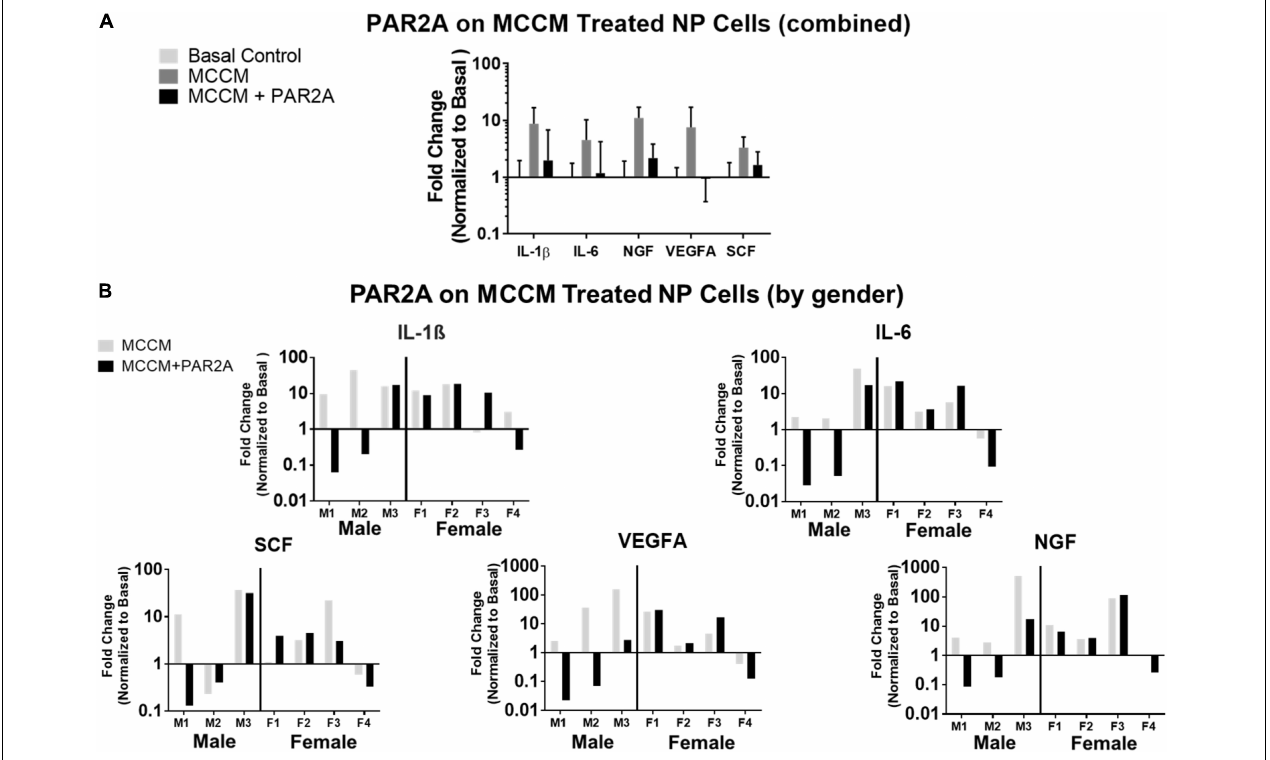
FIGURE 6 | (A) Histogram of average fold change in qRT-PCR gene expression in human NP cells ( N = 7) treated with MCCM and MCCM + PAR2A normalized to basal untreated controls. (B) Histograms of fold changes in qRT-PCR gene expression in human NP cells for individual donors normalized to basal control where left (M1, M2, M3) are males and right (F1, F2, F3, F4) are